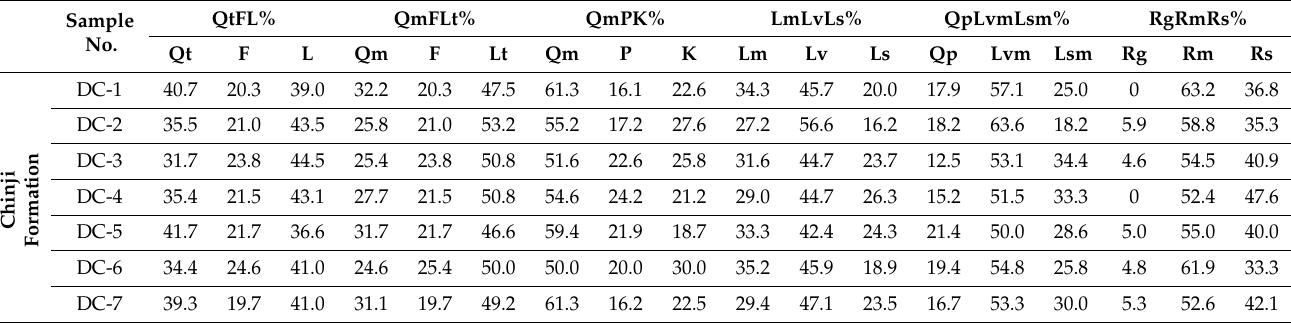
Table 3. Recalculated detrital modes for the sandstone of Siwalik Group (Petrographic param- eters after Ingersoll and Suczek [52]. Where Qt = Total quartz, Qm = Monocrystalline quartz, Qp = Polycrystalline quartz, F = Feldspar, P = Plagioclase, K = Alkali feldspar, L = Lithics, Lt = Total lithics, Lm = Metamorphic lithics, Lv = Volcanic lithics, Ls = Sedimentary lithics, Lvm = Total volcanic and metavolcanic lithics, Lsm = Total sedimentary and metasedimentary lithics, Rs = Sedimentary lithics, Rm = Metamorphic lithics, Rg = Granite